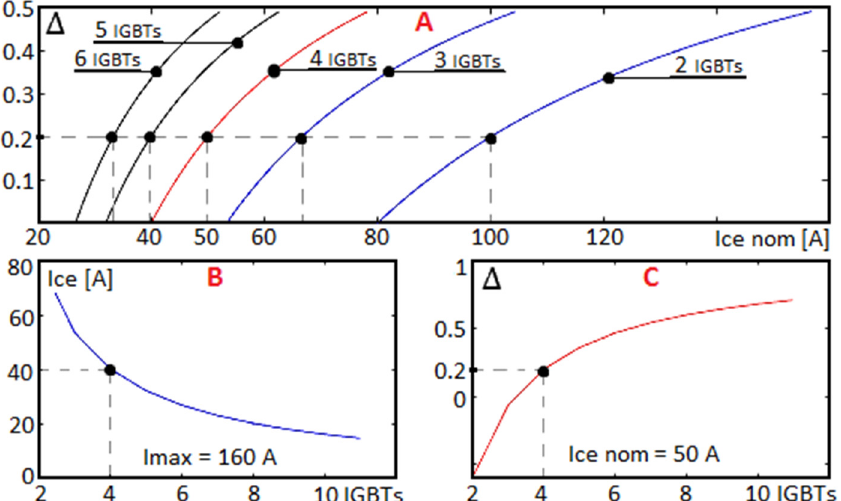
Figure 2. Analysis of the number of IGBTs in parallel. ( A ) Number of transistors in parallel calculated in a derating range ∆ = 0.1 − 0.5, giving the necessary nominal current per transistor; ( B ) expected current through each transistor at the assumed maximum current of I max = 160 A; ( C ) the targeted derating of ∆ = 0.2, i.e., 20%, is feasible with I CEnom = 50 A, 4 IGBTs in parallel. Step 2. Selecting the IGBT, digitalising the necessary datasheet graphics and analysing the obtained data.